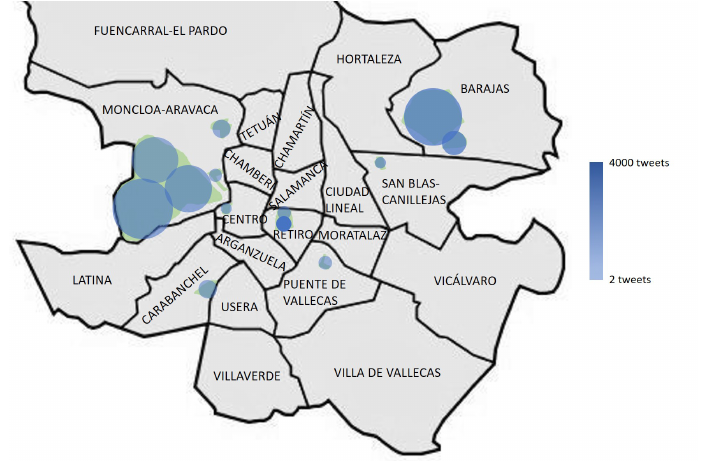
Figure 2. Map of Madrid with the number of collected tweets per